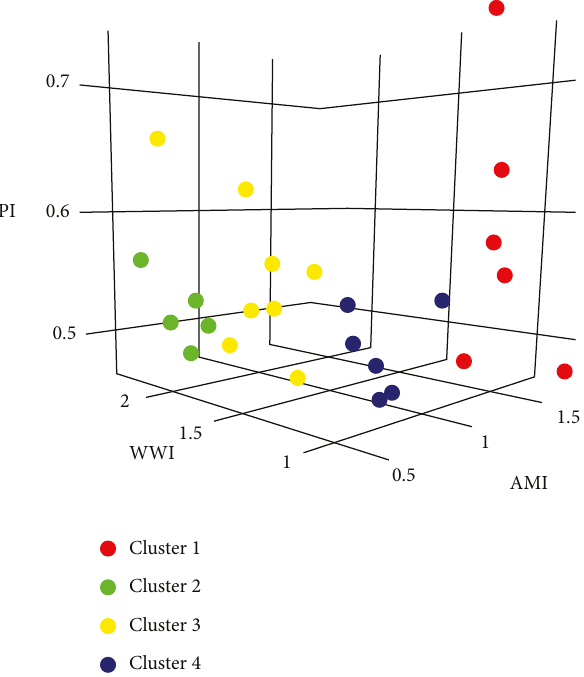
Figure 6: Clusters identified for long-term bicycle counters.